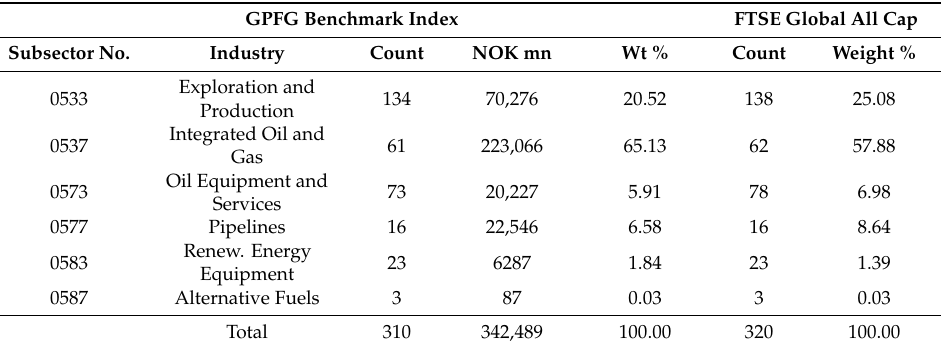
Table 2. The company count and industry weights for companies in the Oil and Gas subsectors in the GPFG and FTSE GEISAC, as well as their market value in the GPFG, as of 31 December 2018. Sources as in Table 1.